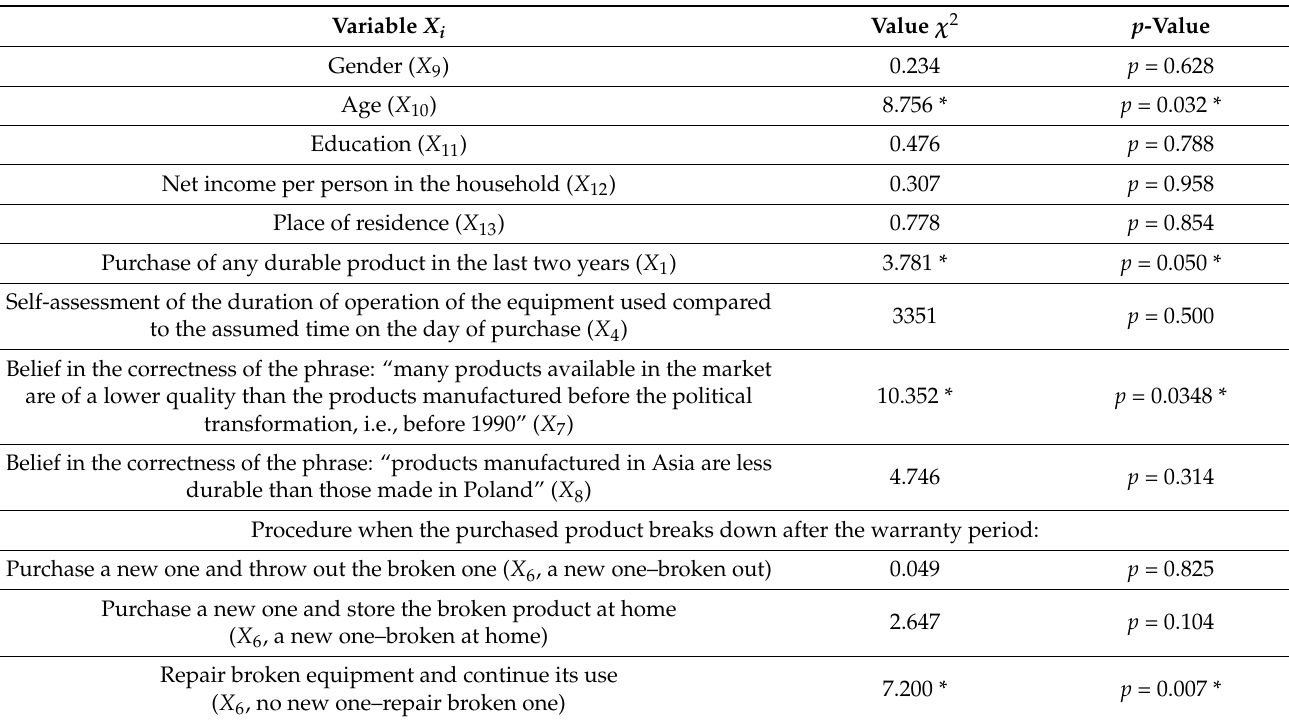
Table 6. Results of the chi-square test of independence for the dependent variable Y and the selected explanatory variables X i .